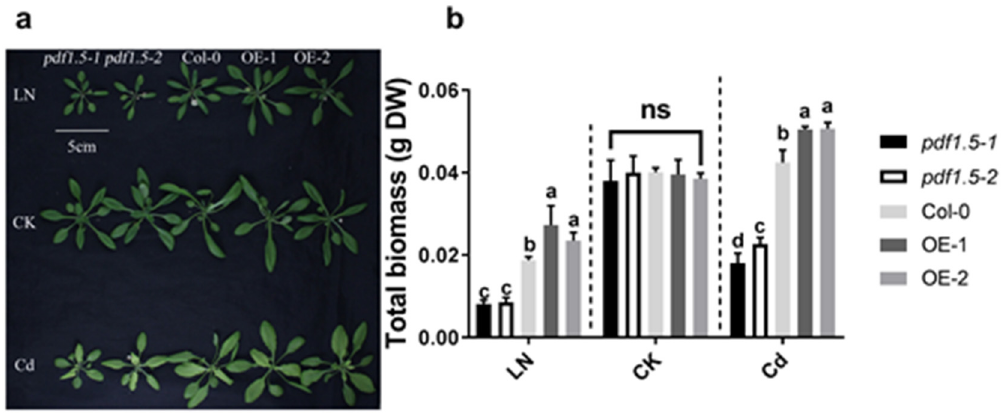
Figure 1. The phenotype for materials grown in low nitrogen (LN), control treatment (CK), or cadmium (Cd) conditions. ( a ) Phenotype for different materials—materials were harvested from 3-week-old hydroponically grown plants in either LN or Cd or CK conditions. ( b ) Total biomass for different materials. Bar height represents mean and error bars indicate standard deviation. Different letters on bars indicate significant differences based on Tukey’s HSD ( p < 0.05). Six replicates were used for measurements.